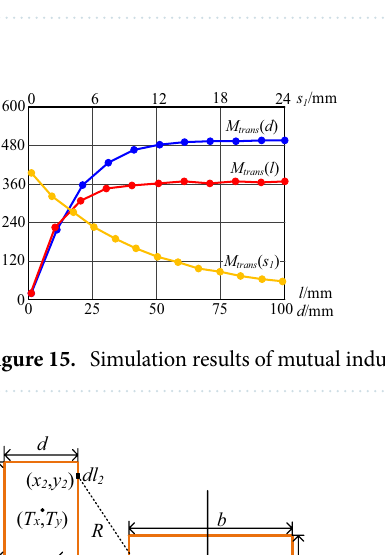
Figure 14. 3D FEA simulation model of transformer leakage inductance and input plug loop (xoy plane view).